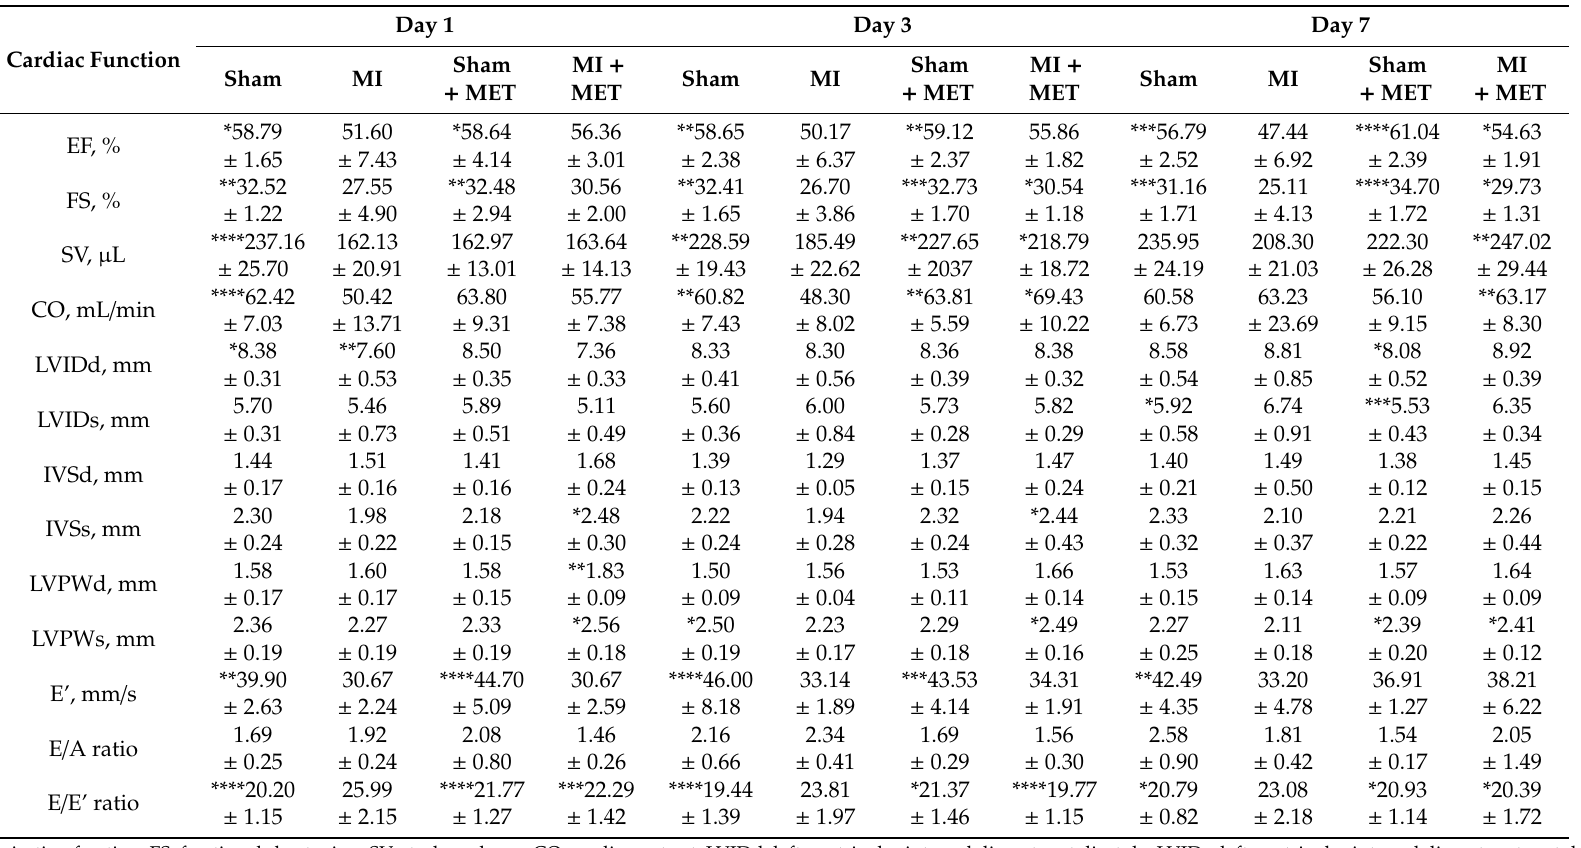
Table 1. Cardiac function measured by